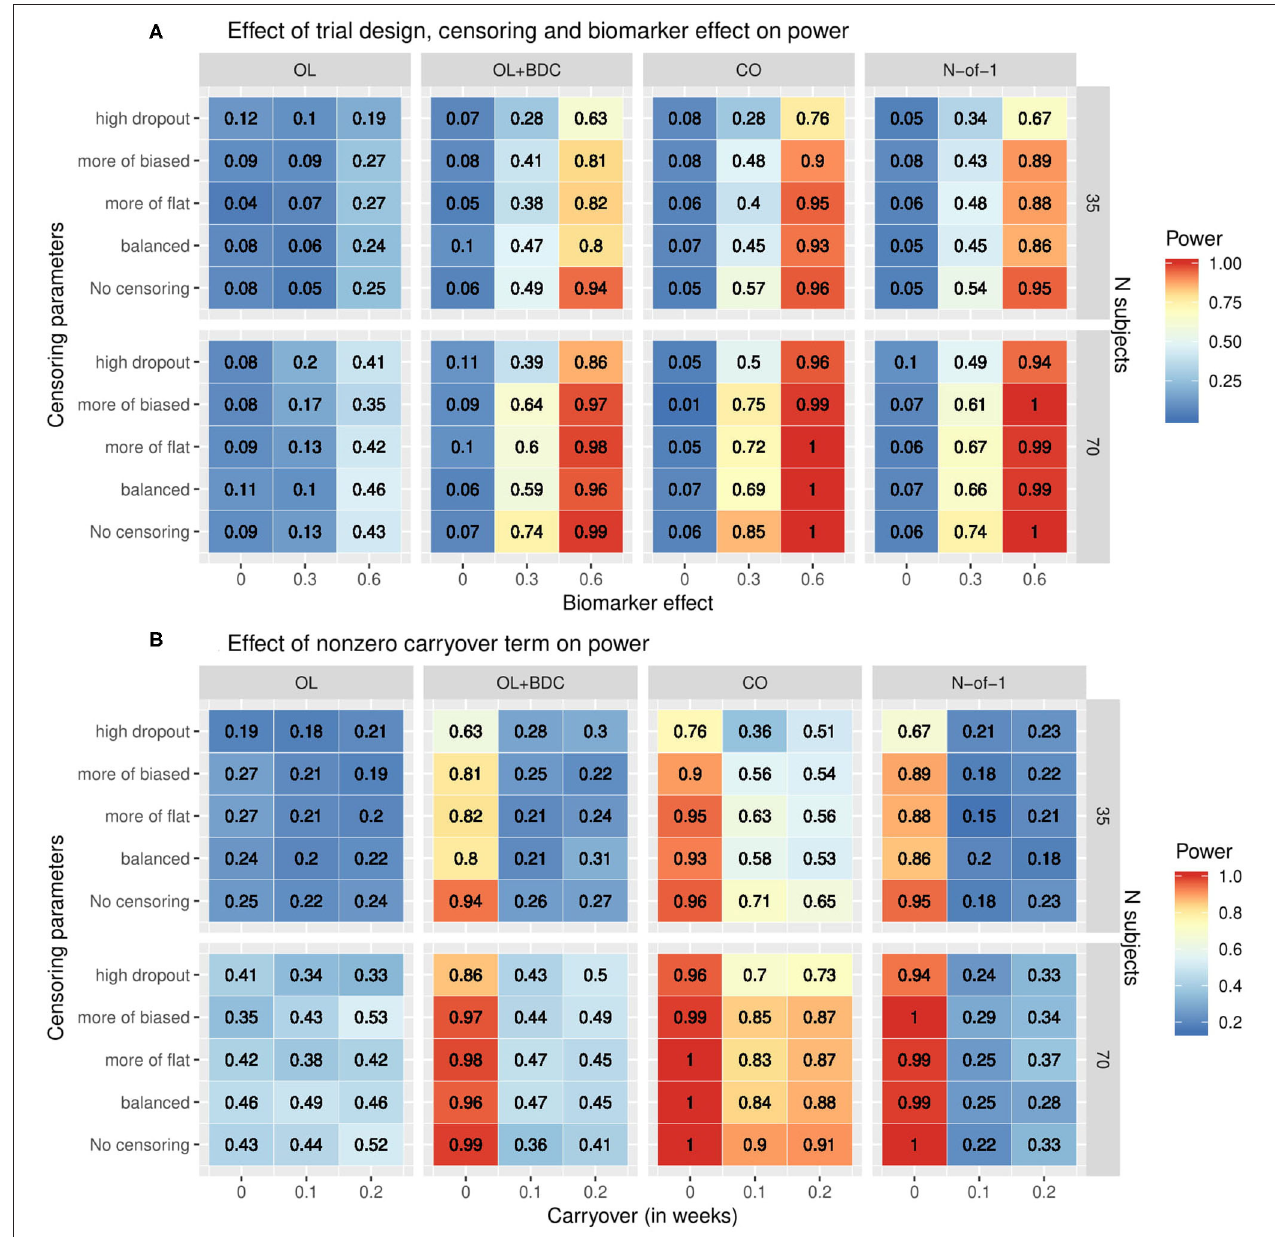
FIGURE 4 | Heat map showing statistical power as a function of (A) clinical trial design, the number of subjects, the correlation coefficient relating the biomarker to the biologic response to drug, and the censoring parameters describing dropout patterns, or (B) clinical trial design, the number of subjects, the timecourse of the carryover effect of the intervention ( t 1 / 2 in weeks), and the censoring parameters describing dropout patterns, for each of the clinical trial designs described in figure 1 . In (A) the carryover effect is set to zero; in (B) the correlation between baseline biomarker and the biologic response to drug is set to 0.6. OL = open label, OL + BDC = open label followed by blinded discontinuation, CO = cross over, N-of-1 = proposed N-of-1 trial design.